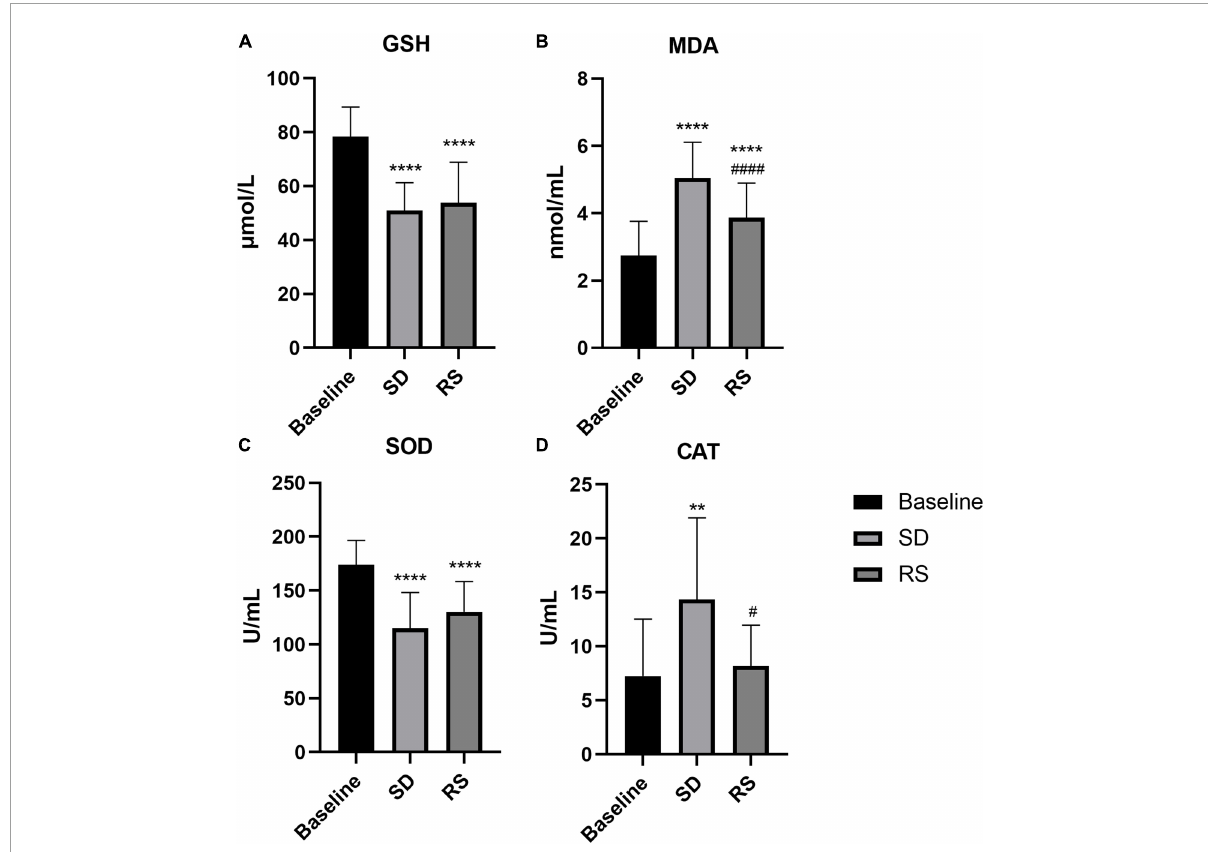
FIGURE5 Plasma GSH (A) , MDA (B) , SOD (C) , and CAT (D) levels or activity measurements before and after SD and RS. ** P < 0 . 01 compared to Baseline, **** P < 0 . 0001 compared to Baseline, # P < 0 . 05 compared to SD, #### P < 0 . 0001 compared to